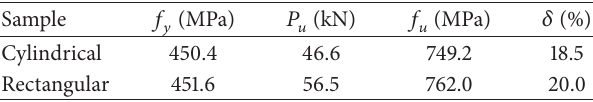
Table 2: Mechanical properties of SAE 1045 steel [3].